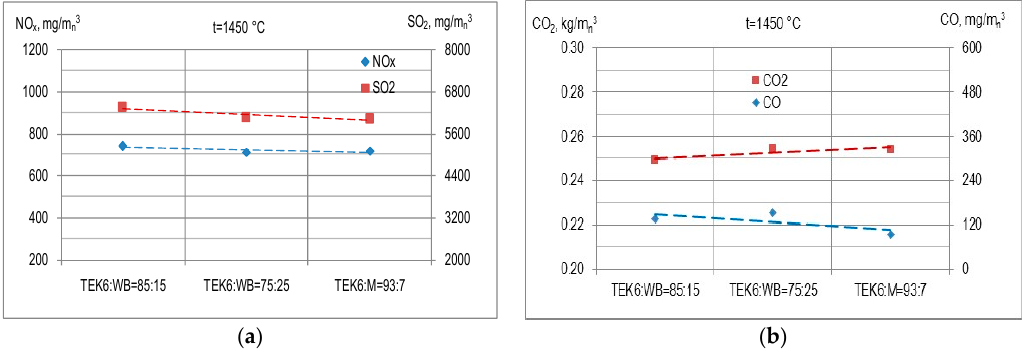
Figure 6. Emissions for different biomass co ‐ firing with coal TEK6, ( a ) NO x and SO 2 emissions ( b ) CO and CO 2 emissions.